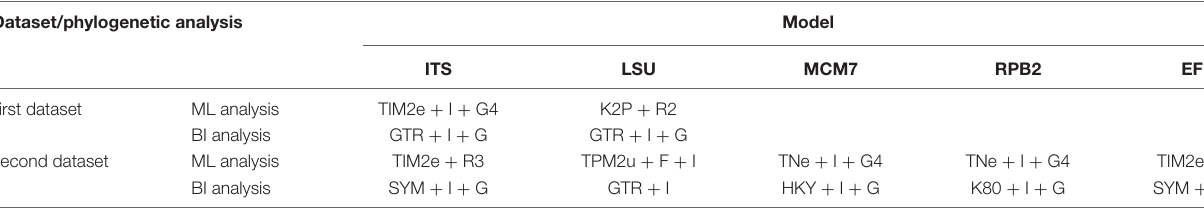
TABLE 2 | The best-fit evolutionary model in the phylogenetic